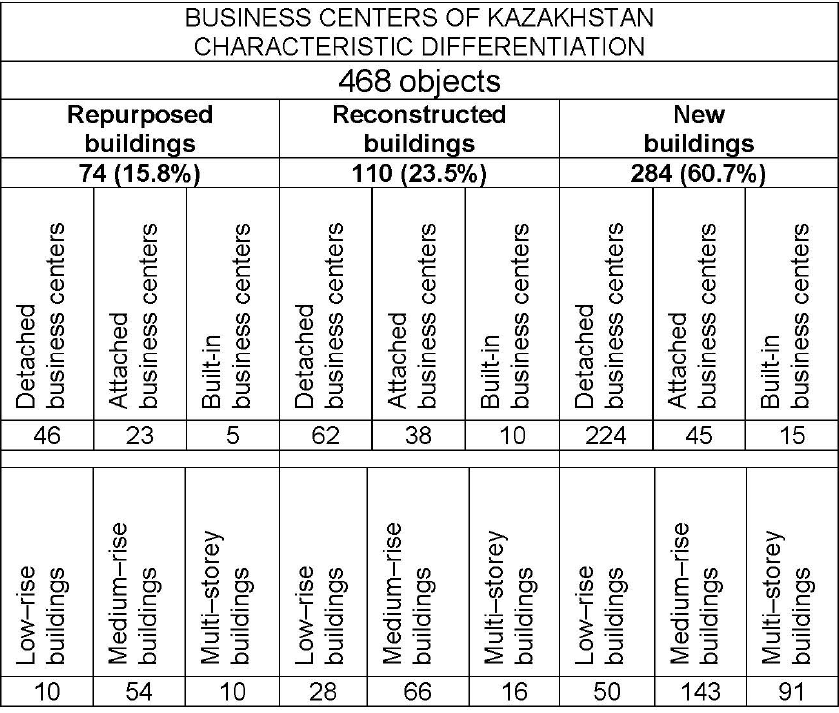
Figure 24. Business centers of Kazakhstan, by characteristic differentiation.